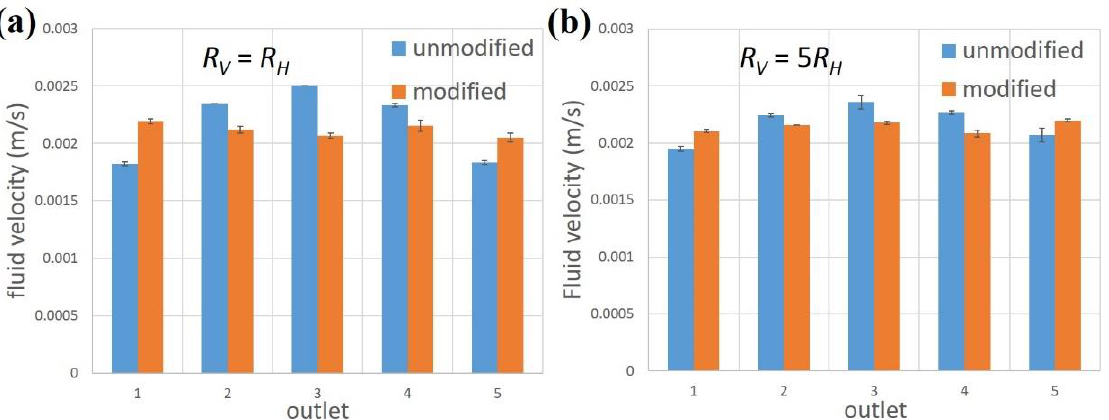
Figure 9. Experimentally measured fluid velocities for unmodified and modified microfluidic chips with ( a ) R V = R H and ( b ) R V = 5 R H .